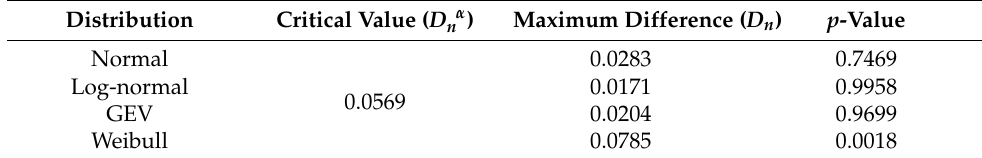
Figure 9. (a) Comparison of PDFs and (b) goodness of fit test results. Figure 9. ( a ) Comparison of PDFs and ( b ) goodness of fit test results. Table 5. Kolmogorov-Smirnov test results. Table 5. Kolmogorov-Smirnov test results.